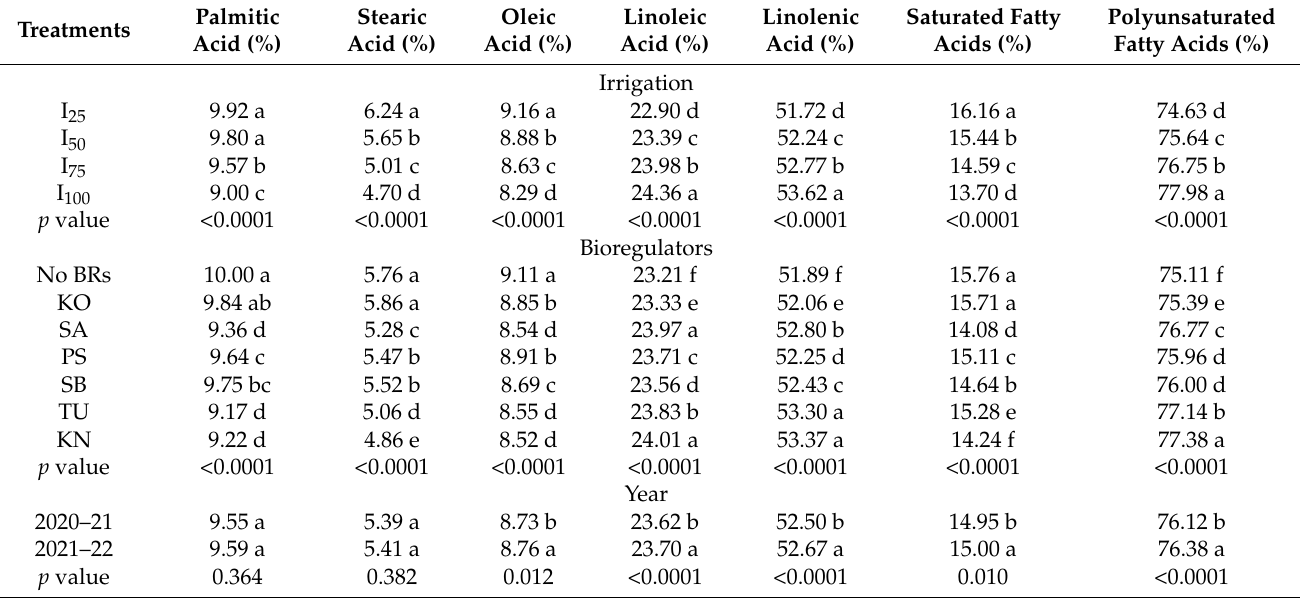
Table 4. Changes in fatty acid composition of chia seed oil affected by deficit irrigation regimes and bioregulators